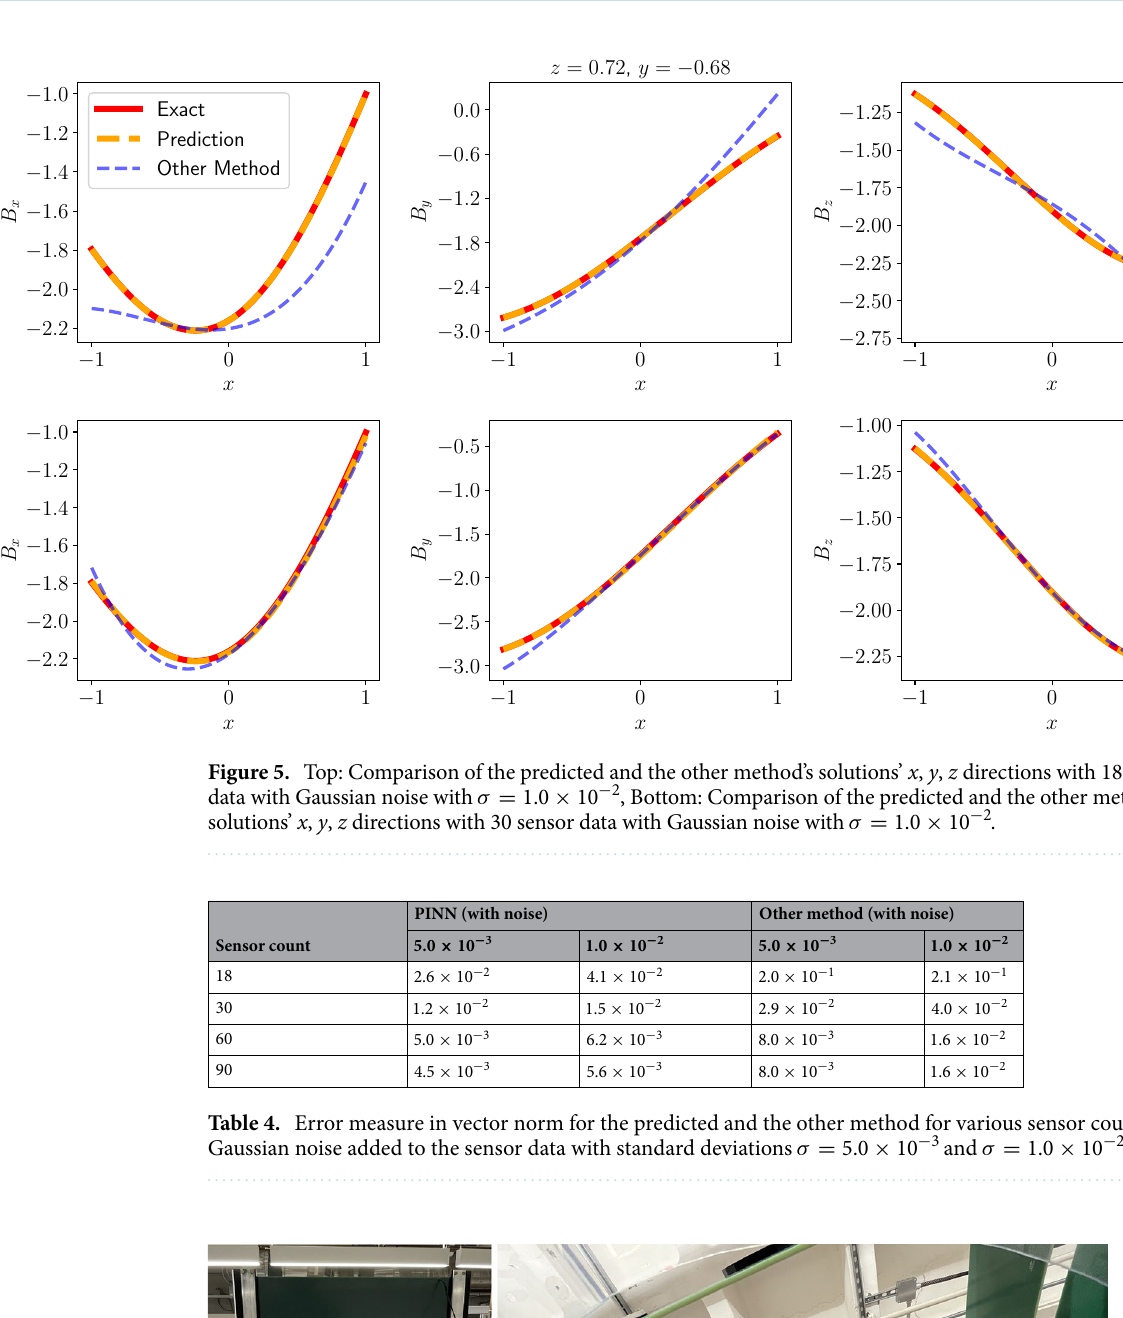
3 2 and σ = 1.0 × 10 − .